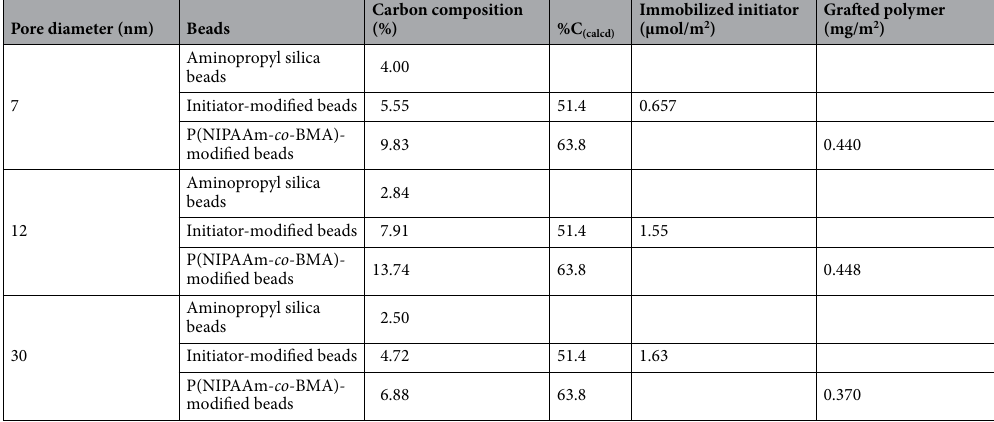
Table 1. Characterization of temperature-responsive hydrogel-modified beads using CHN elemental analysis. Carbon composition was determined through CHN elemental analysis. %C (calcd) was calculated as the percentage of the molecular weight of carbon in the initiator and copolymer. The amounts of initiator and polymer on silica beads were estimated using the carbon composition.